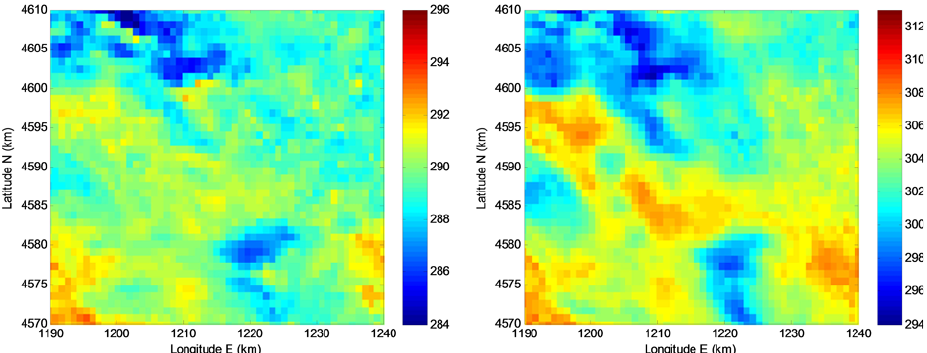
Fig. 5. Estimated T a on 1 January 2006 (left) and on 1 July 2006